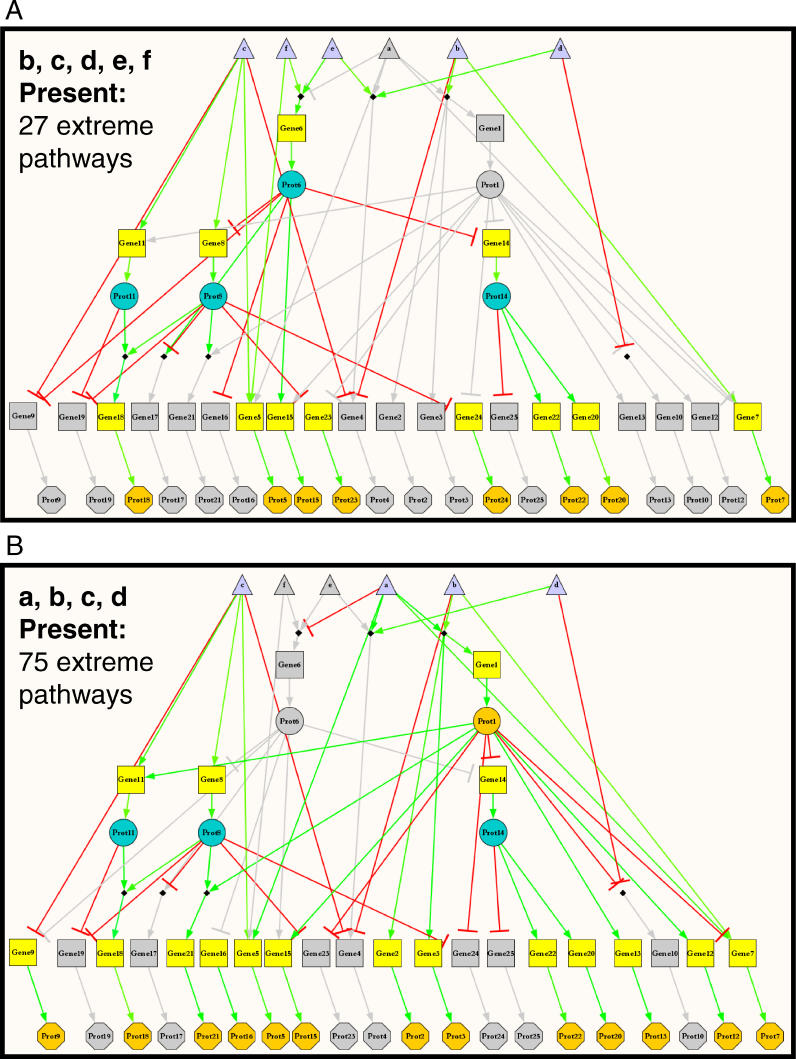
Expression States for the Prototypic TRS for Two Additional EnvironmentsThe expression (i.e., functional) states for two different environments, as generated by extreme pathway analysis of R*, are presented.(A) The expression states for the environment in which Metabolite a is absent but all other metabolites are present are shown. This environment yields 27 extreme pathways, the least of all possible environments, leading to the activation or inactivation of the genes within the TRS.(B) The expression states for the environment in which Metabolite e and Metabolite f are absent but all other metabolites are present are shown. This environment yields 75 extreme pathways, the most of all possible environments, leading to the activation or inactivation of the genes within the TRS. A legend for these drawings is described in the caption for Figure 8.